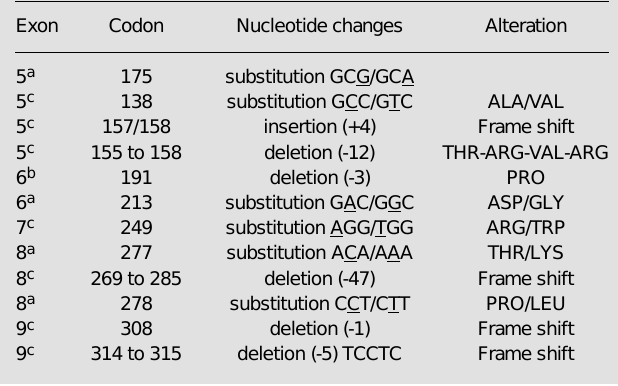
Table 1 - p53 Gene mutations in human